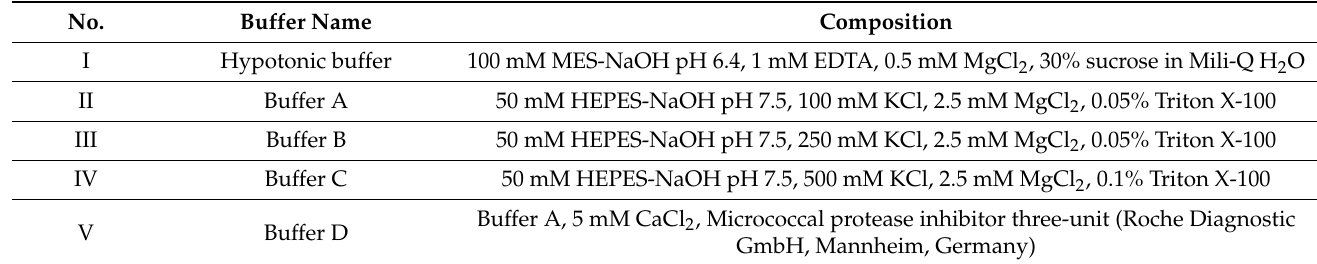
Table 1. Constitution of trapping assay